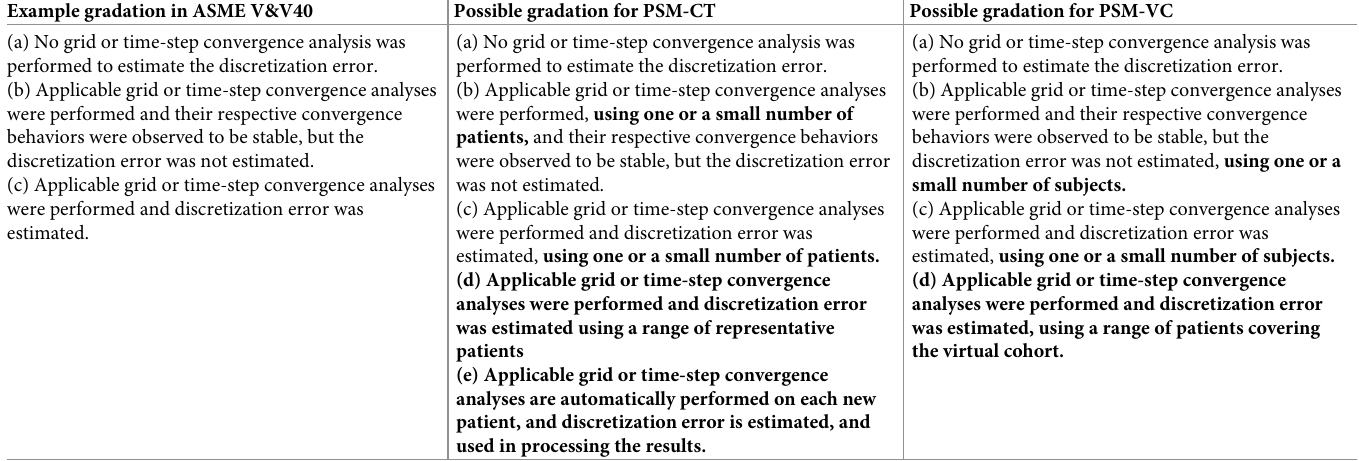
Table 6. Original V&V40 gradation for the ‘Discretization Error’ credibility factor, and example possible gradations for PSM-CT and PSM-VC. Changes highlighted in bold. [Original V&V40 example gradations reprinted from ASME V&V 40–2018, by permission of The American Society of Mechanical Engineers. All rights